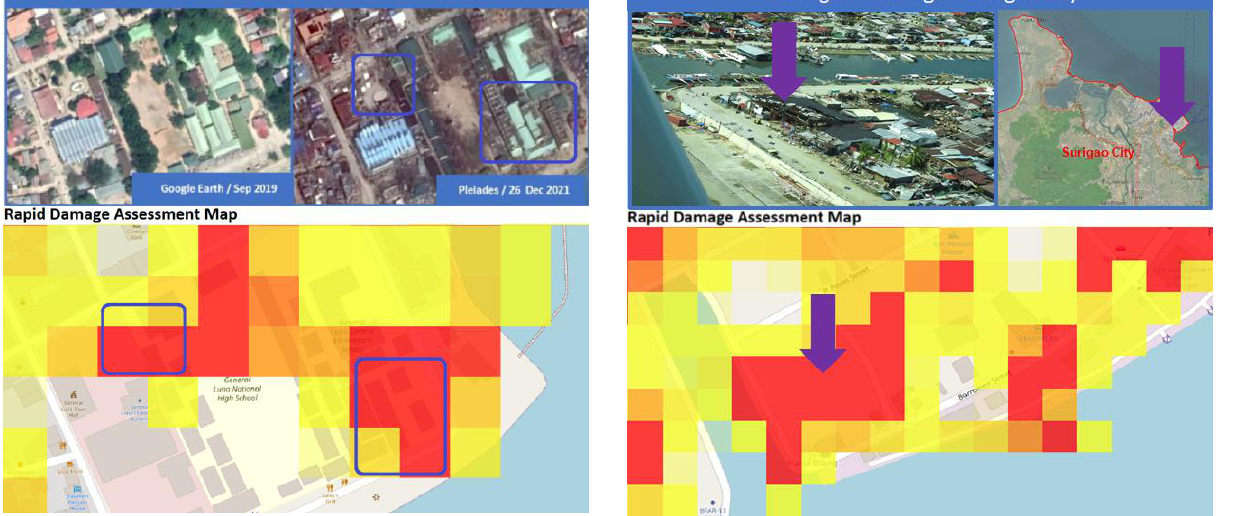
Figure 8. Rapid damage assessment map as validated using aerial observations from the Philippine Coast Guard. Here we can see the severely damaged infrastructure is indeed under the severely damaged block (red) in the SAR-derived damage map. Photo © PCG, 2022. Basemap © OSM 2022.